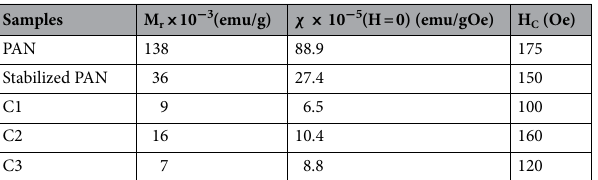
Table 2. Obtained values for remanent magnetization, initial magnetic susceptibility and coercivity of the PAN-based carbon fibers.